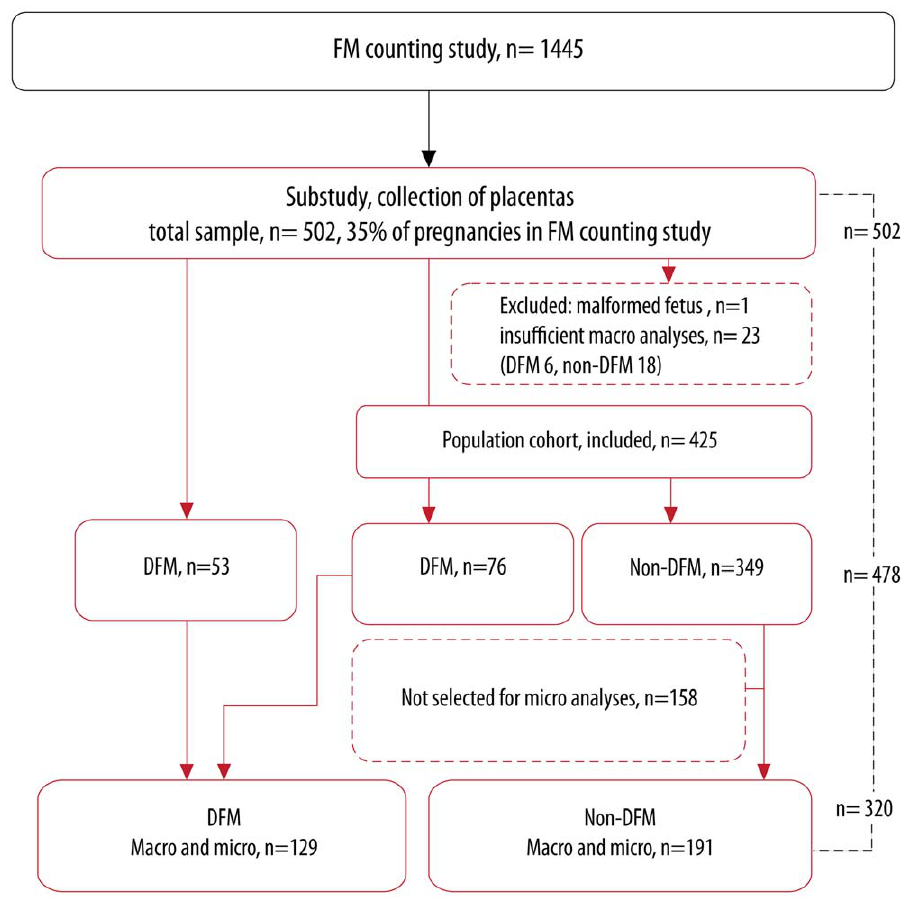
Figure 1. Flowchart for data collection.